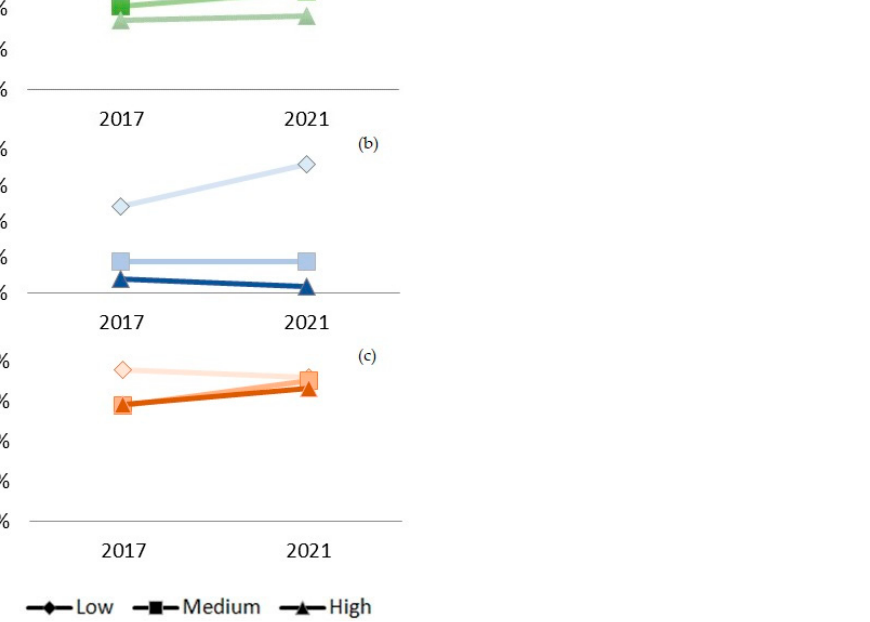
Figure 1. Crude prevalence of an adequate diet (DQI score > 42) by educational level among adults in Madrid from 2017 to 2021: ( a ) overall; ( b ) for women; ( c ) for men.